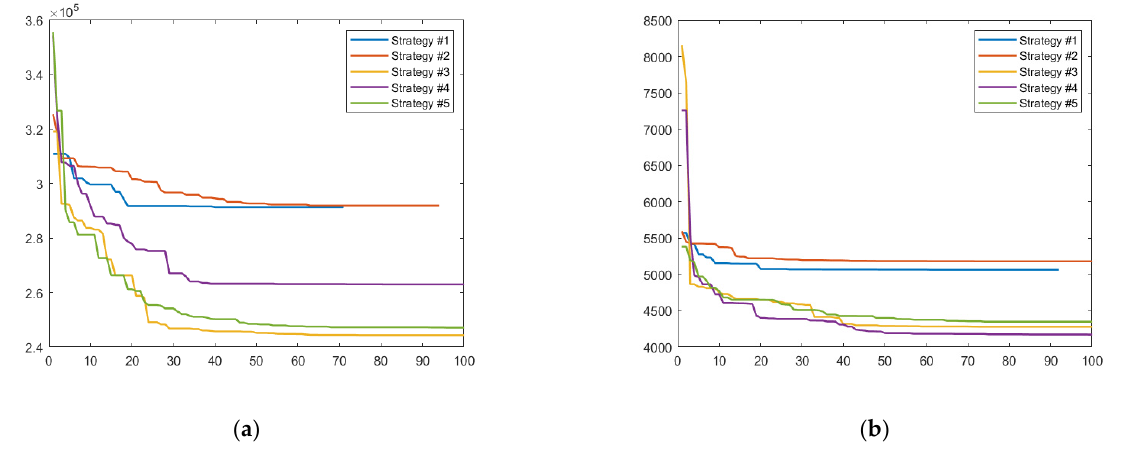
Figure 24. Fitness function evolutions for all strategies: (a) when minimizing V ovf ; (b) when minimizing OQI.